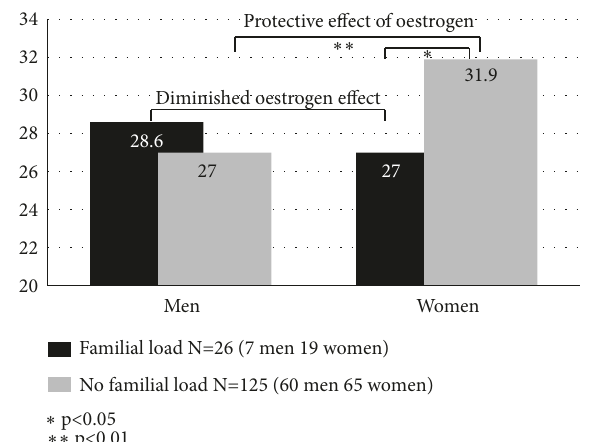
Figure 7: Age at first psychotic symptom by gender and familial load; ABC first-episode sample of schizophrenia (N=232). Source: